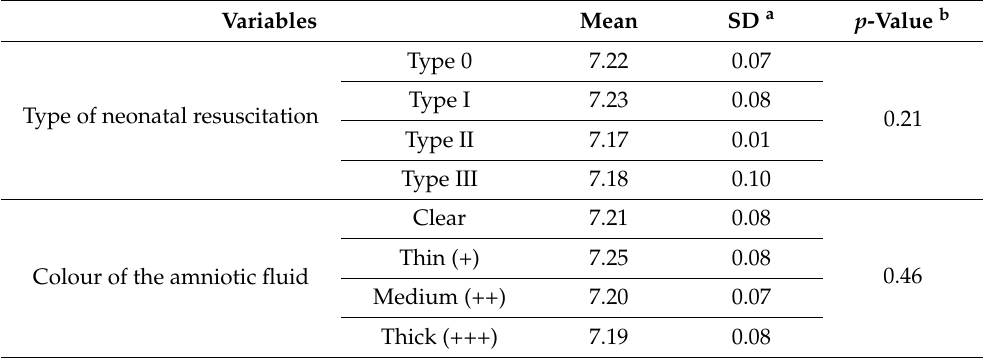
Table 2. Comparison of the foetal scalp pH based on the type of neonatal resuscitation required and the colour of the amniotic fluid.